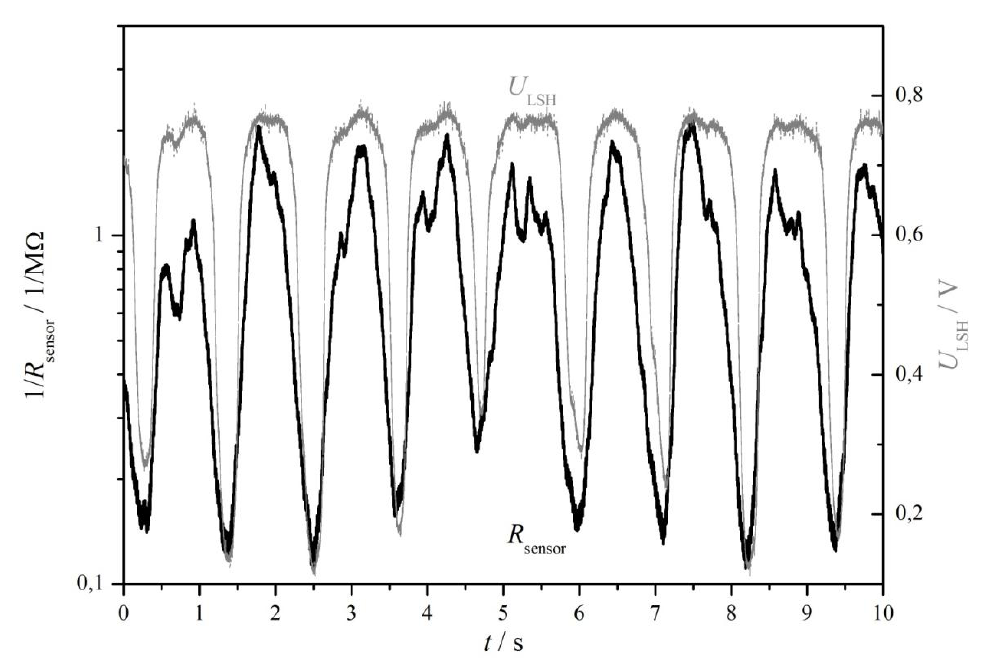
Figure 8. Comparison of the three-way catalyst sensor conductance (1/ R voltage of a binary  probe, U (Bosch type LSH) at the engine outlet during typical LSH operation. From [91], reprinted with kind permission from Springer Science+Business Media